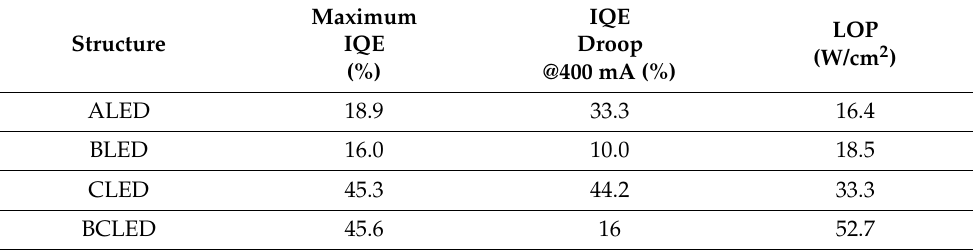
Figure 2. ( a ) Comparison of output power and ( b ) IQE plots of ALED, BLED, CLED and BCLED with respect to the current density. Table 1. Comparison between Maximum IQE, Efficiency Droop, and Light Output Power of Different Structures.